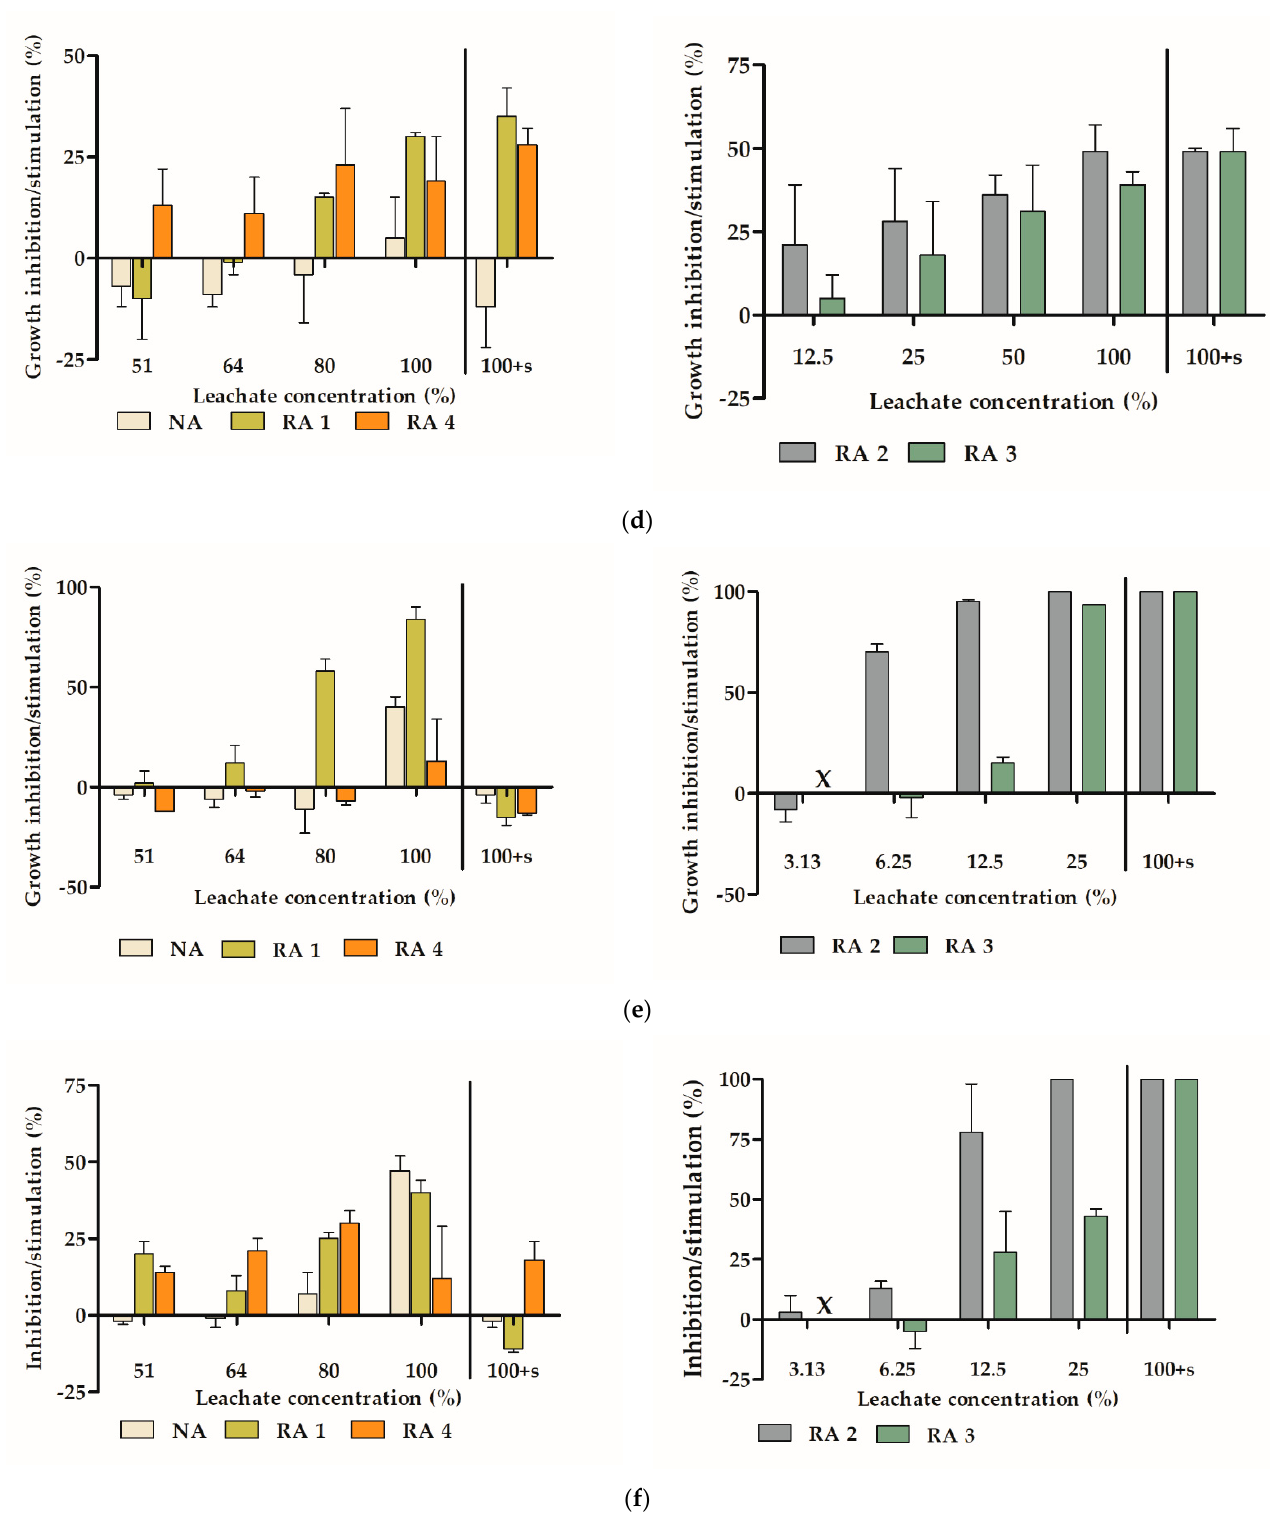
Figure 4. The results of ecotoxicity experiments: ( a ) Daphnia immobilization, ( b ) algae growth rate, ( c ) algae chlorophyll content, ( d ) mustard root elongation, ( e ) Lemna growth rate, ( f ) Lemna chlorophyll content. X—not determined, 0—zero values, 100 + s—leachates amended with nutrient salts.